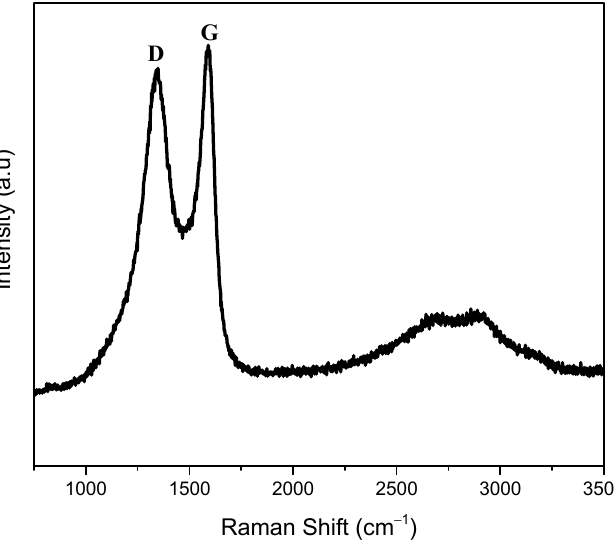
Figure 2. Raman spectra of LIGE.